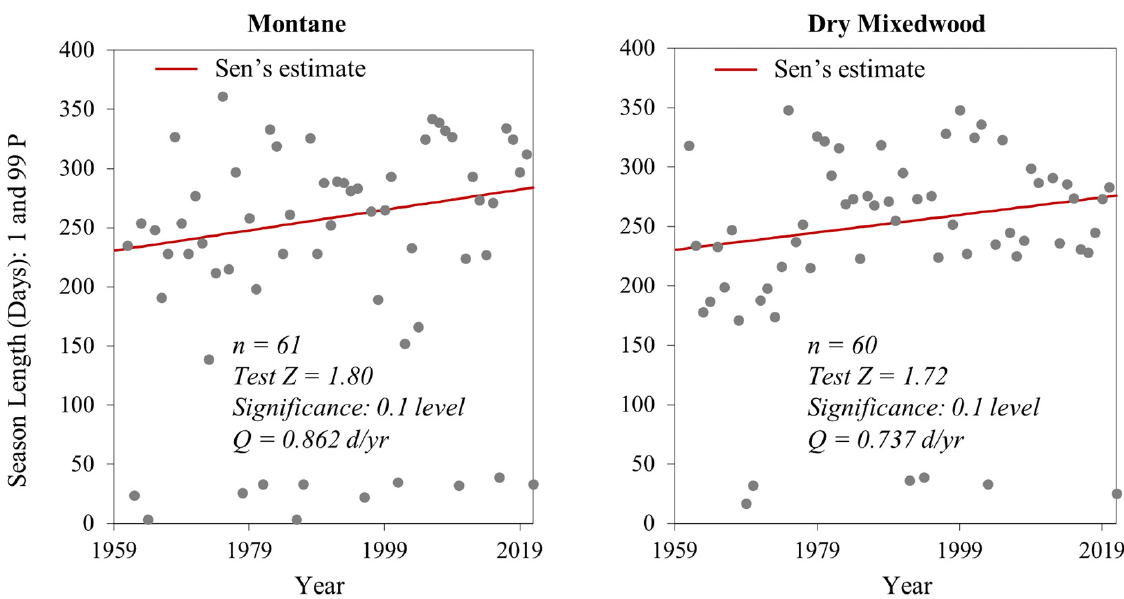
Figure 5. Trends of the forest fire season in the natural subregions of Alberta over the period 1959 ‒ 2021 with significance levels of 99% (*) and 95% ( + ). Slopes (day/year) of fire season start and end dates ( a ), and length ( b ) were determined using 1st and 99th, and 5th and 95th percentiles.